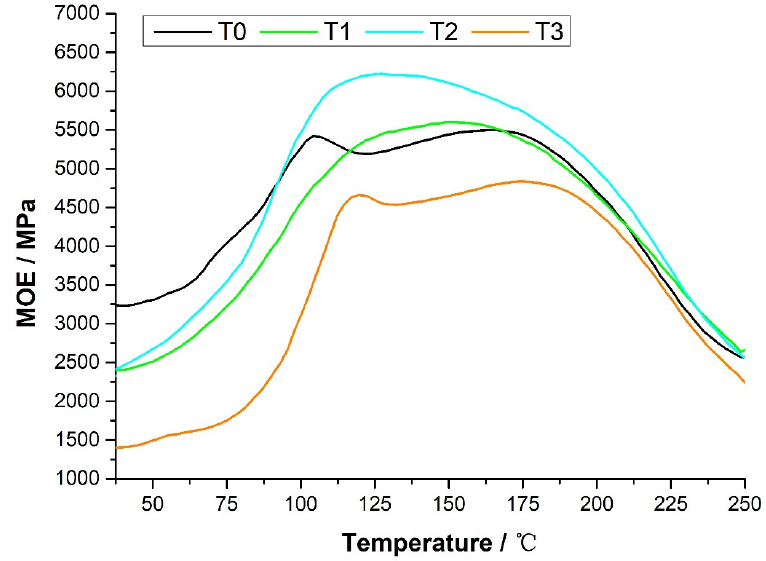
Figure 2. TMA curve of the highly branched polymer-modified tannin